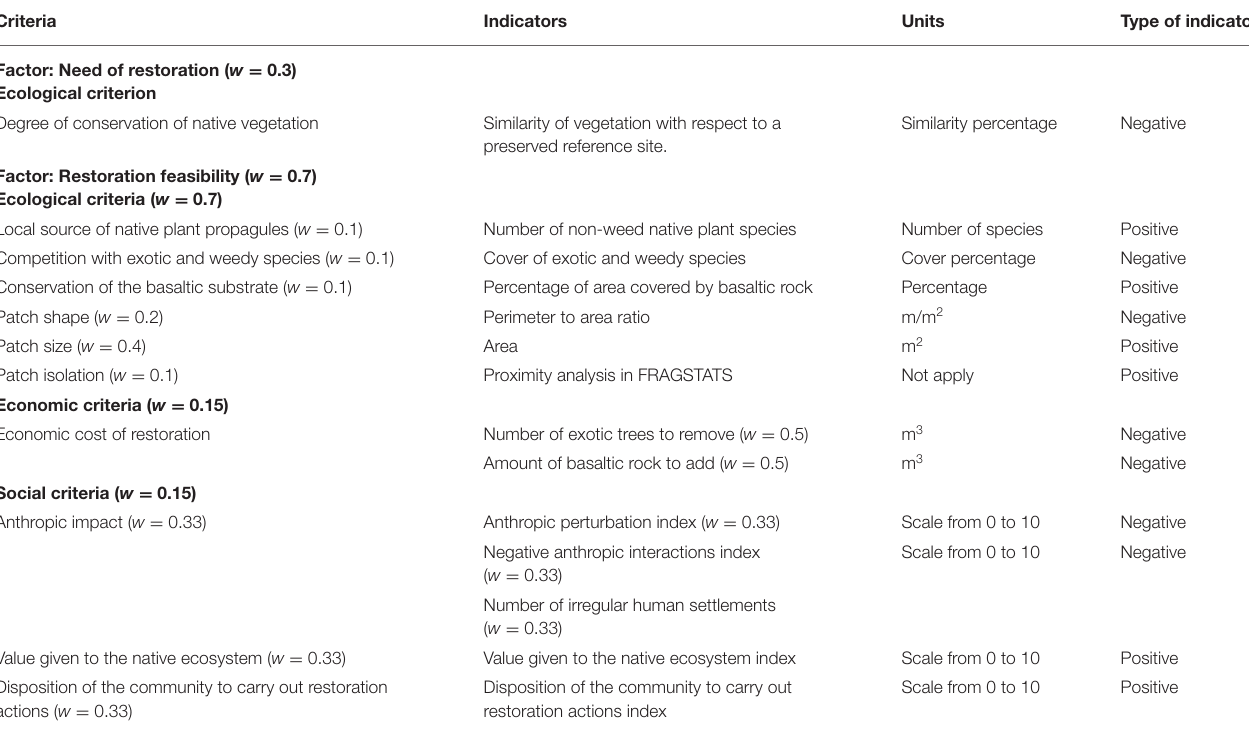
TABLE 1 | Ecological, economic, and social criteria and indicators to evaluate the need and feasibility. Criteria Indicators Units Type of indicator Factor: Need of restoration ( w = 0.3) Ecological criterion Degree of conservation of native vegetation Similarity of vegetation with respect to a Similarity percentage Negative preserved reference site.